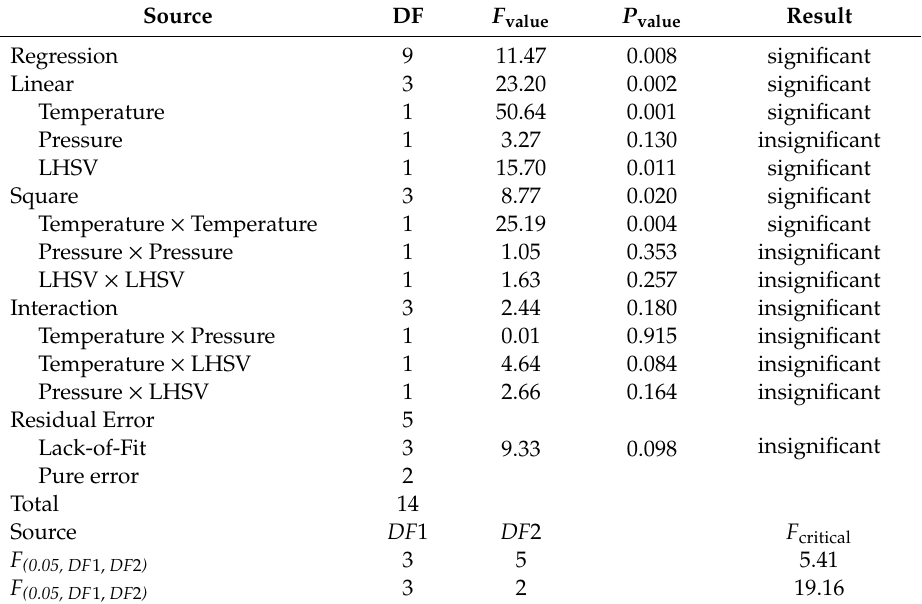
Table 3. Analysis of variance for kerosene